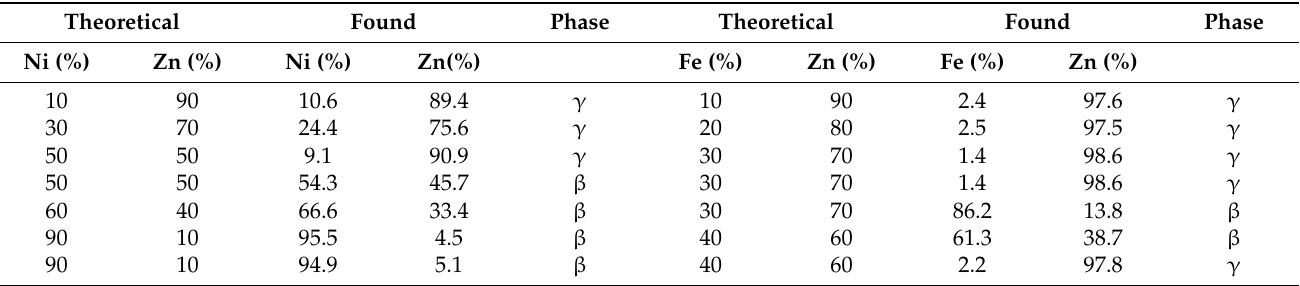
Table 9. Metal assay by EDX of [M x Zn (1 − x ) (bpy) 3 ](PF 6 ) 2 according to metal proportion and